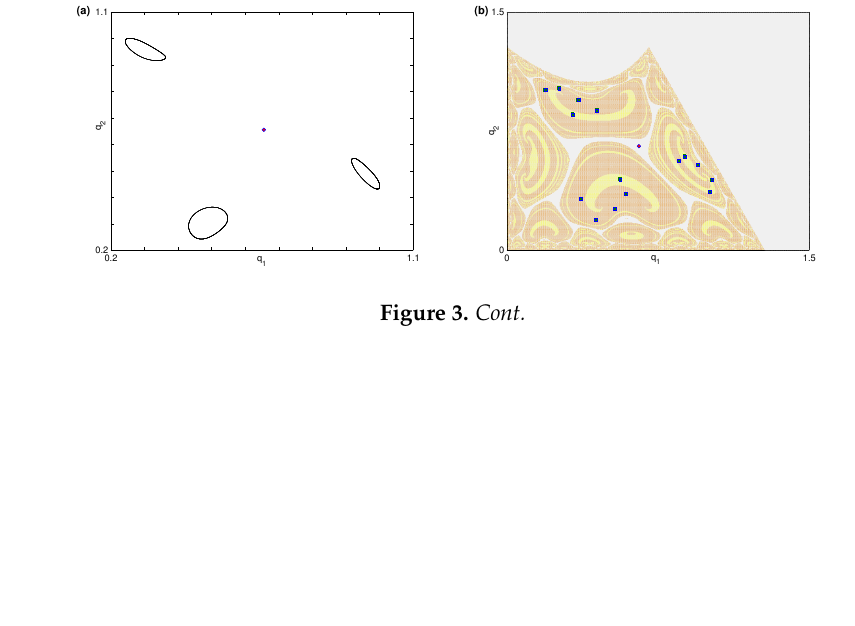
Figure 2. ( a ) The phase plane of the chaotic attractor at k = 4.59. ( b ) The basin of attraction of period-7 cycle at k = 4.6436. ( c ) The phase plane of seven closed chaotic areas at k = 4.65. ( d ) The phase plane of the chaotic attractor at k = 4.66. ( e ) Neimark-Sacker bifurcation on varying k and a = 2, b = 0.9, c = 0.1. ( f ) The basin of attraction of the period-3 cycle at k = 1.43 and a = 2, b = 0.9, c = 0.1.